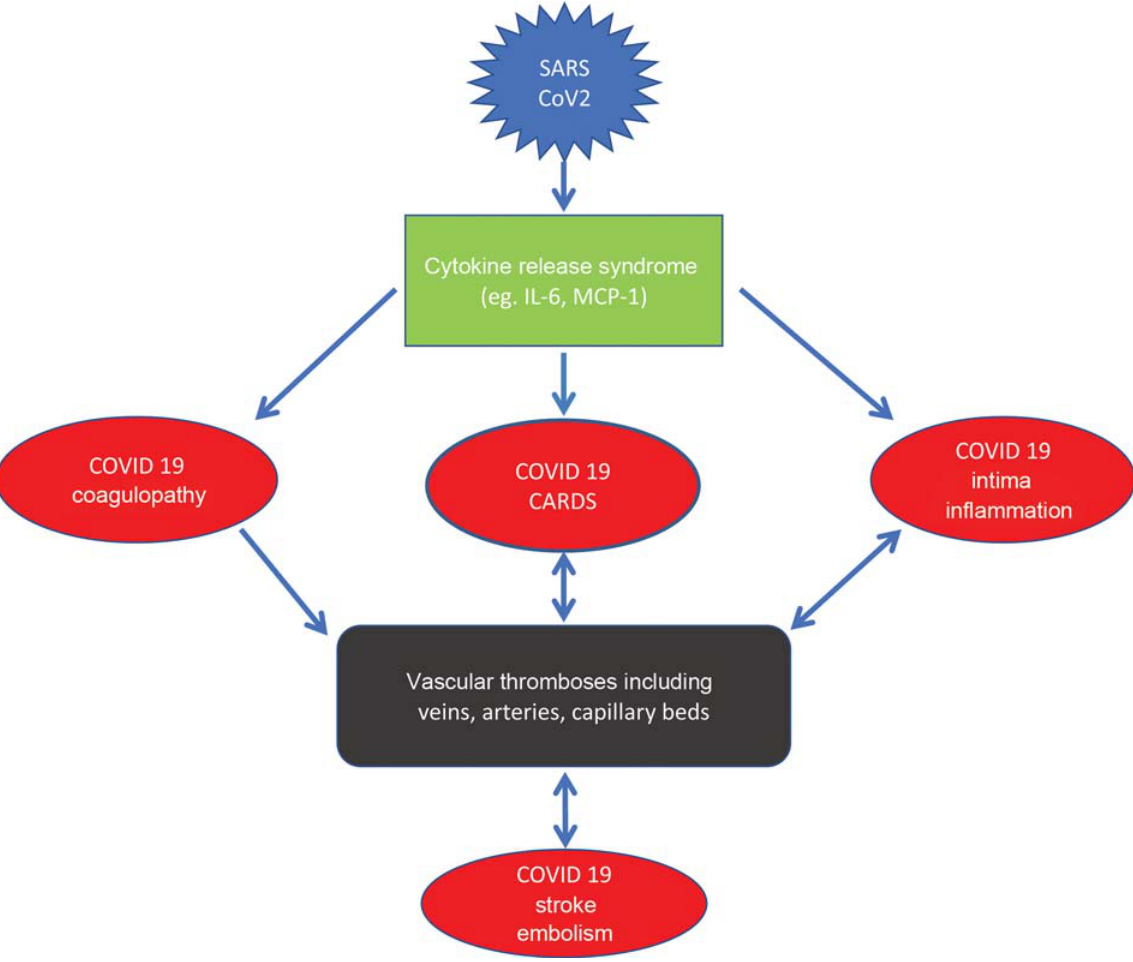
Fig. 8 Summary fi gure about cytokine release syndrome (CRS) in COVID-19. CRS is associated adult respiratory stress syndrome (ARDS) of the lungs, vascular intimal in fl ammation and coagulopathy with increased incidence of thromboembolic complications. COVID-19, novel coronavirus disease 2019; CRS, cytokine release syndrome; MCP, monocyte chemoattractant protein; SARS-CoV-2, severe acute respiratory syndrome –